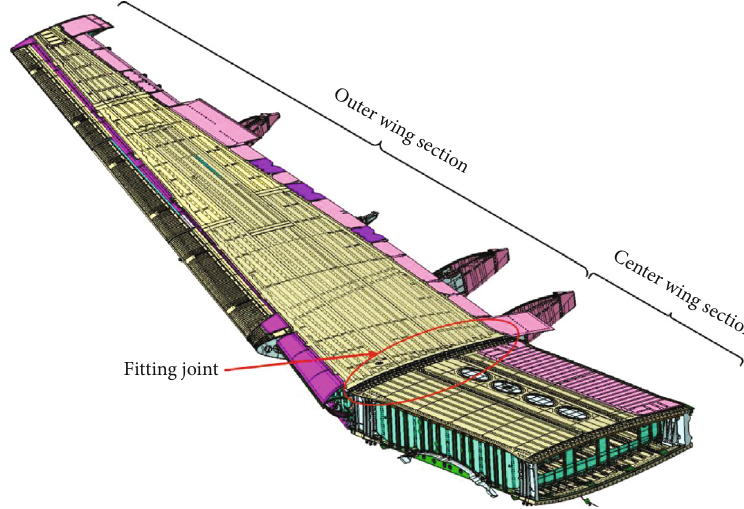
Figure 1: The fi tting joint between the center wing section and the outer wing section of the aircraft AN-148.